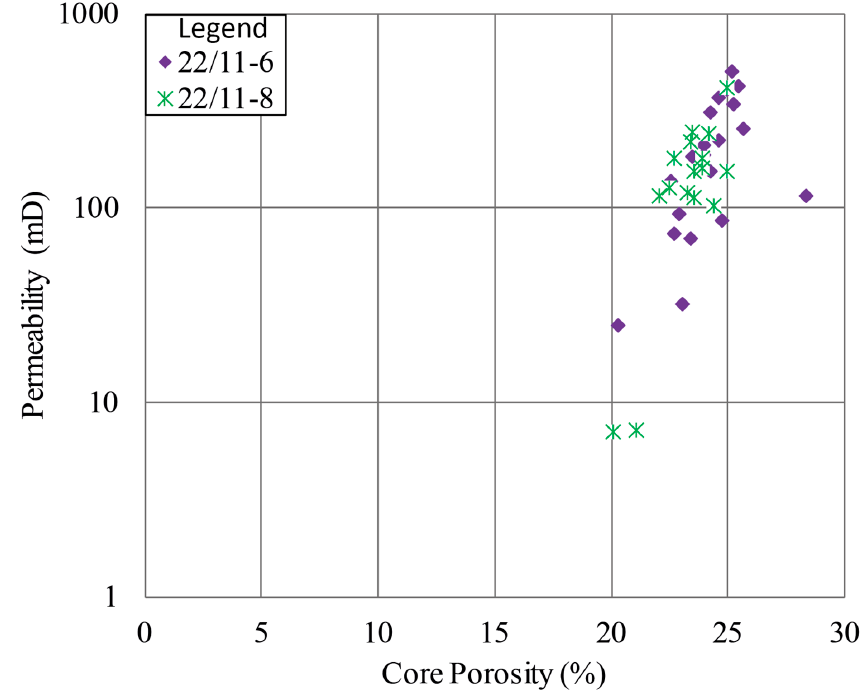
Figure 10. Reservoir porosity and permeability data for the Forties Sandstone Member. The data shows a positive correlation between the two parameters.